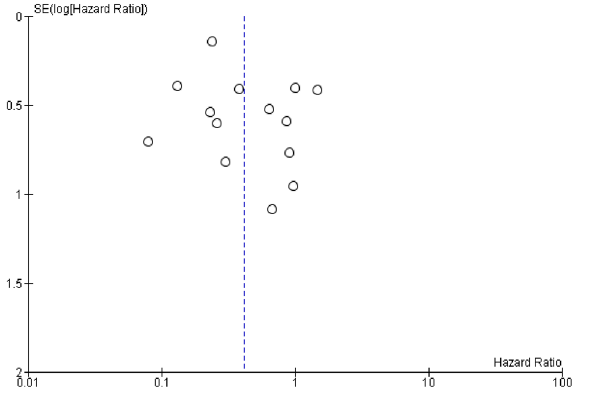
Figure 4. Funnel plot for publication bias for overall